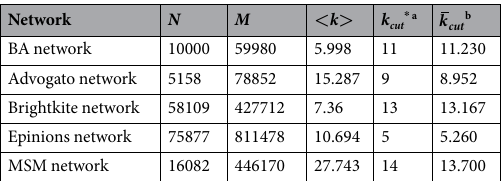
Table 1. Statistics of experiment networks. a k cut * is obtained from the real average degree and degree distribution of a network. b k is the average of 100 simulation results. cut